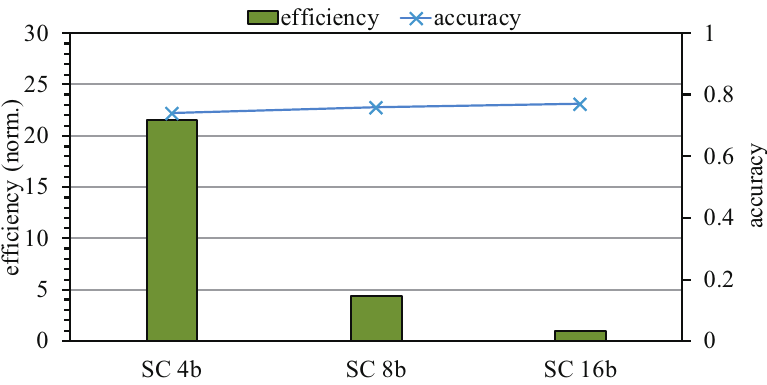
Figure 19. Trade-off analysis of SCA